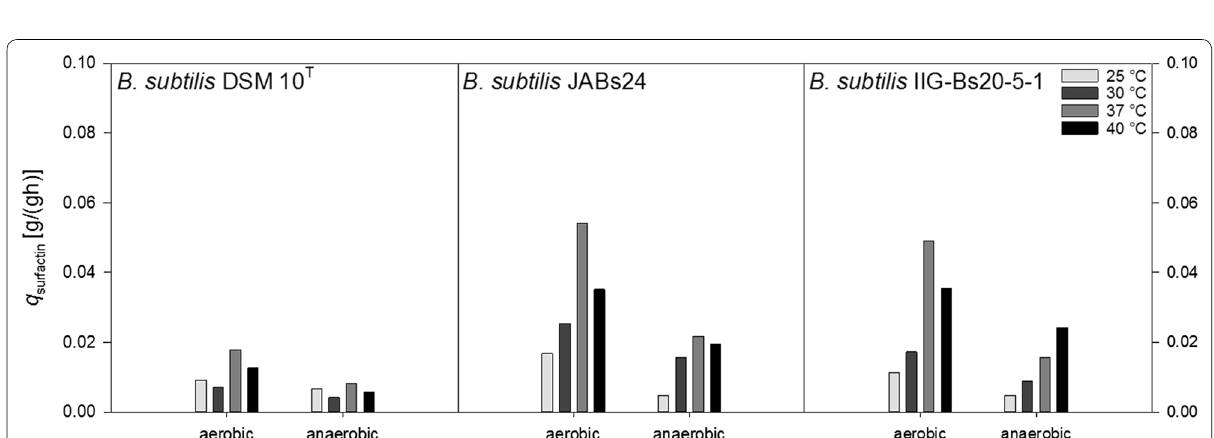
Fig. 5 Overview of the calculated surfactin productivities q surfactin (g/g h) for strains B. subtilis DSM 10 T , B. subtilis JABs24 and B. subtilis IIG-Bs20-5-1 under aerobic and anaerobic conditions at 25 °C, 30 °C, 37 °C and 40